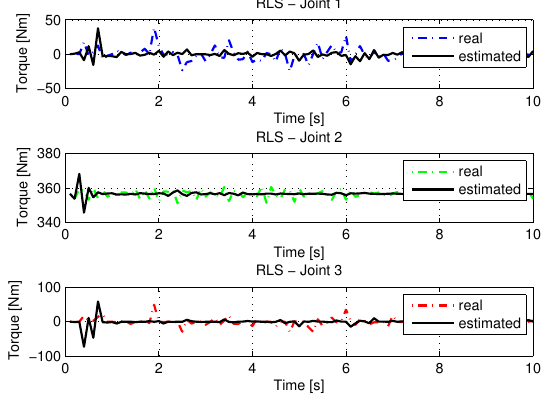
Figure 31. Torque of joints with RLS with